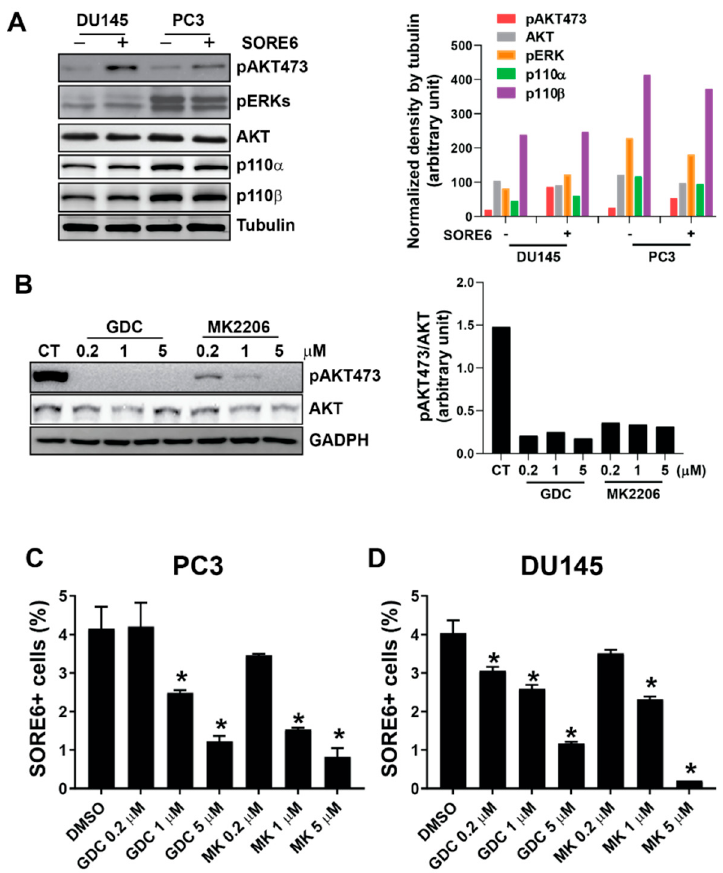
Figure 5. PI3K/AKT signaling is upregulated in SORE6 + cells. ( A ) The sorted SORE6 + and SORE6 − PC3 and DU145 cells were analyzed by Western blotting for the expression of the indicated proteins. Left panel, representative images; right panel, densitometric analysis of the indicated protein expression normalized by tubulin. ( B ) The effect of the GDC0941 (GDC) and MK2206 treatments on AKT phosphorylation. Left panel, representative images; right panel, densitometric analysis of pAKT473 levels normalized by total AKT. The original blots for Figure 5A,B can be found in Figures S2 and S3. ( C , D ) The effect of the GDC0941 (GDC) and MK2206 treatments on the SORE6 + fraction in ( C ) PC3 and ( D ) DU145. * p < 0.05 versus DMSO, n = 3–4.